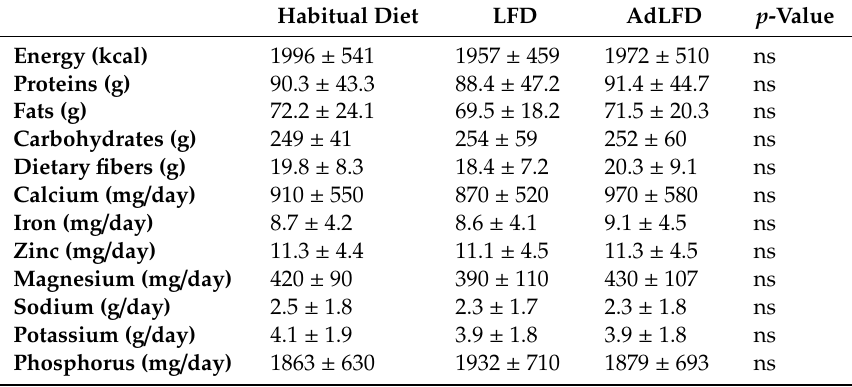
Table 2. Mean dietary intake of patients at baseline (habitual diet) and on a low-FODMAP (fermentable oligosaccharides, disaccharides, monosaccharides and polyols diet) (LFD). No significant di ff erence